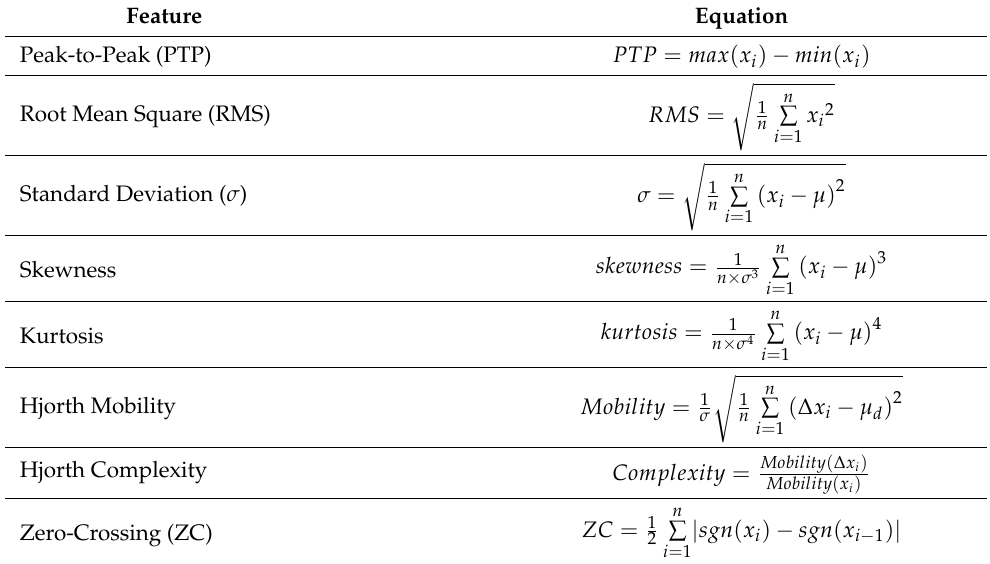
Table 1. Temporal features extracted from the x, y, and z axes of the accelerometer data. The variables x i , n , and µ each refer to the accelerometer data along the temporal axis, the total number of epoched data, and the average of each epoch, respectively. The symbol ∆ denotes the first derivative, and the function sgn indicates the signum function that returns 0 if the input is equal to 0, 1 if the input is positive, and − 1 if the input is negative.